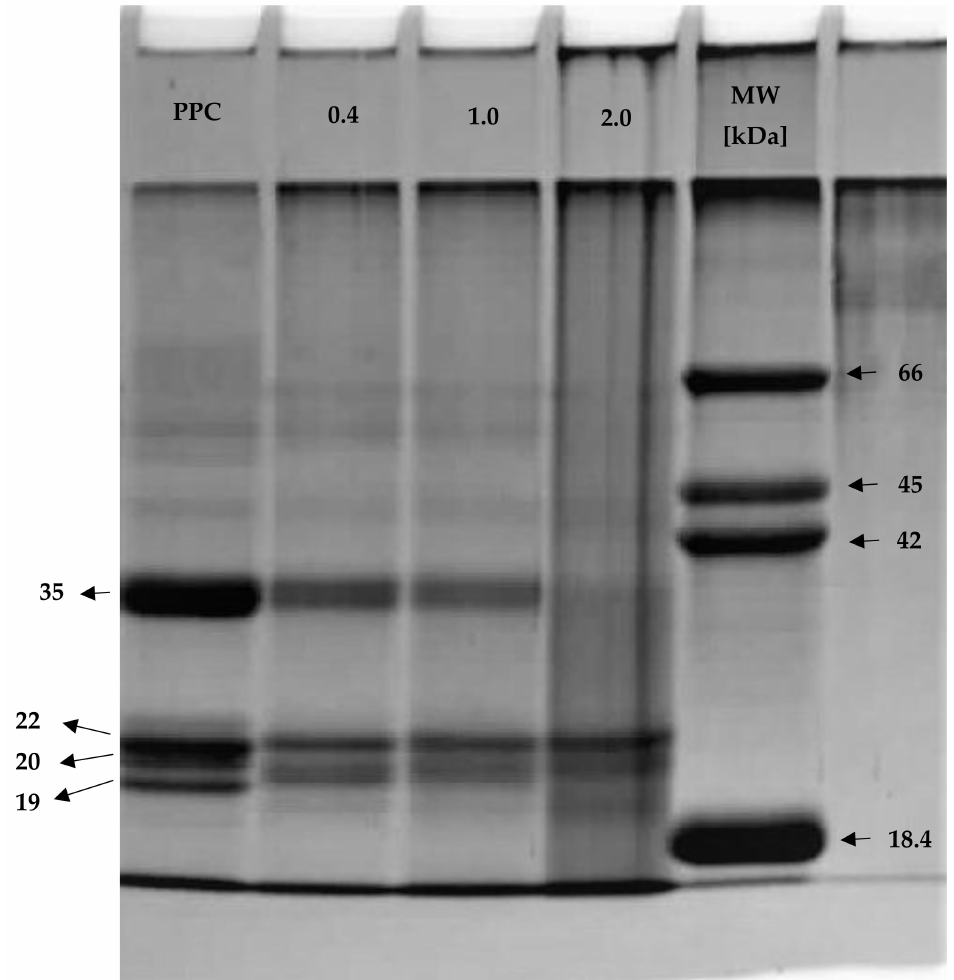
Figure 1. SDS-PAGE of native and acetylated PPC. PPC—pumpkin protein concentrate; 0.4, 1.0, 2.0—pumpkin protein preparations after acetylation conducted with different concentrations